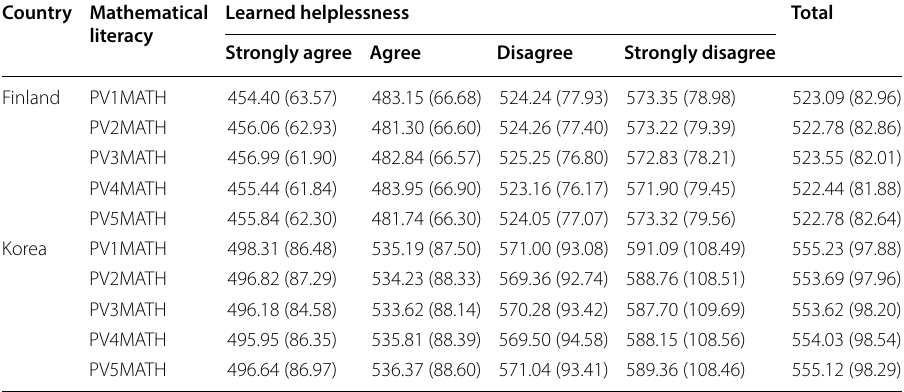
Table 3 Weighted means and standard deviations of mathematical literacy Country Mathematical